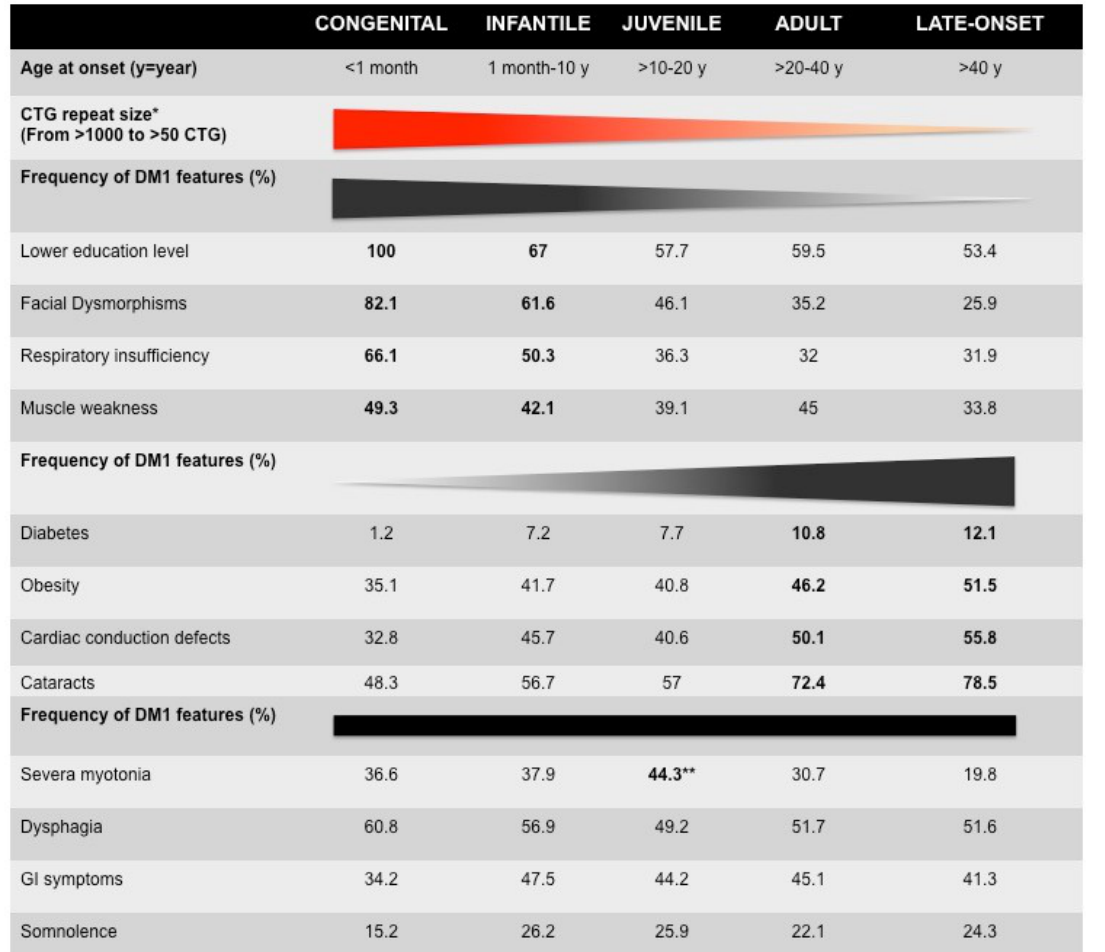
Table 1. Genetic characteristics of French DM1 cohorts  7  . SD = standard deviation.